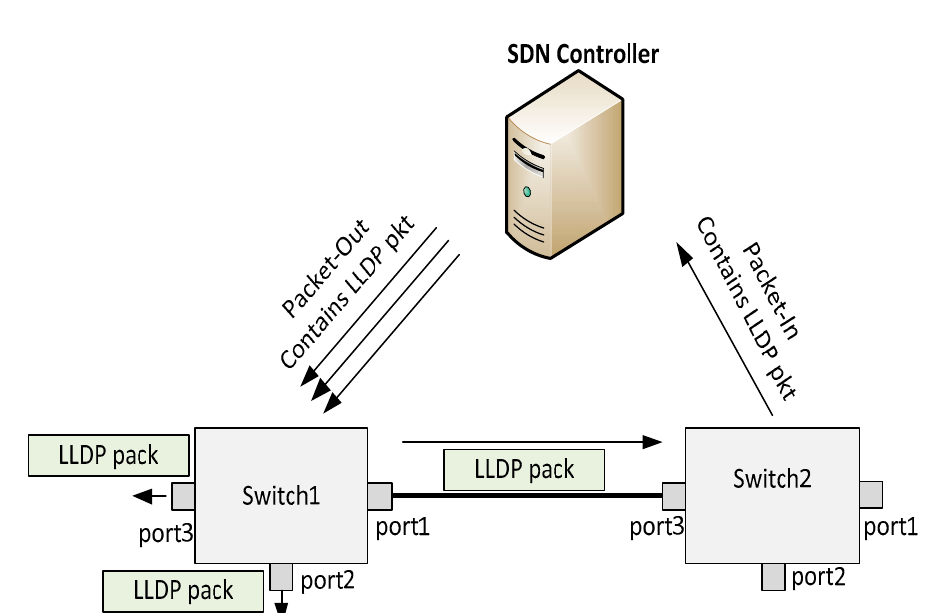
Figure 4. OpenFlow Discovery Protocol (OFDP) topology discovery simple scenario. SDN: Software Defined Networking.